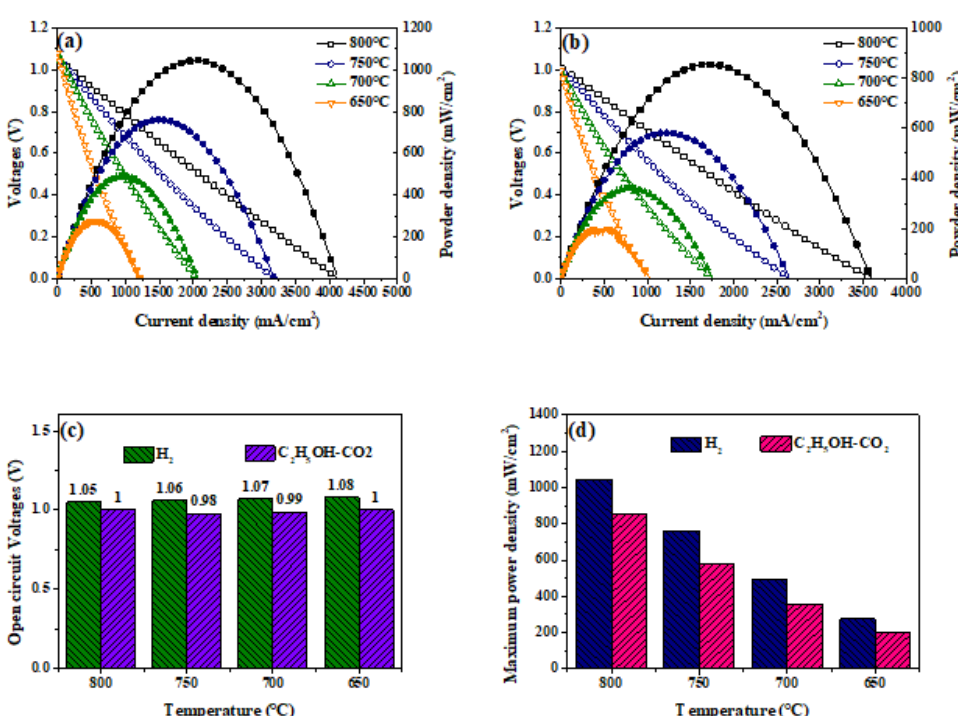
Figure 6. I-V-P curves of single cell with N-LSCFC-GDC reforming catalyst from 800 °C to 650 °C in ( a ) H 2 (~3% H 2 O) and ( b ) C 2 H 5 OH-CO 2 atmosphere; ( c ) OCVs and ( d ) MPD of single cell with N-LSCFC reforming catalyst.